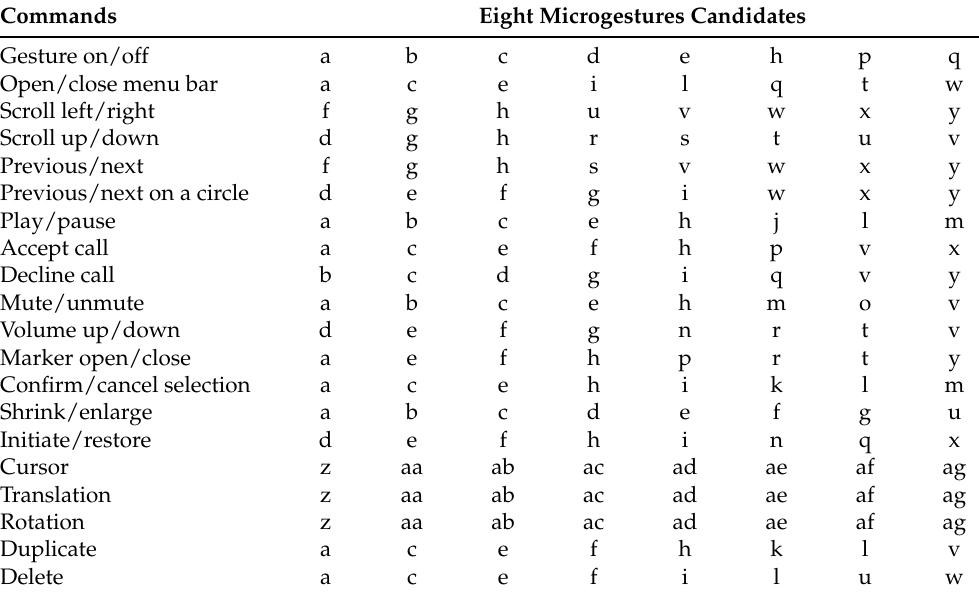
Table 3. Twenty commands with eight pre-selected microgestures (gesture numbers from Figure 1).